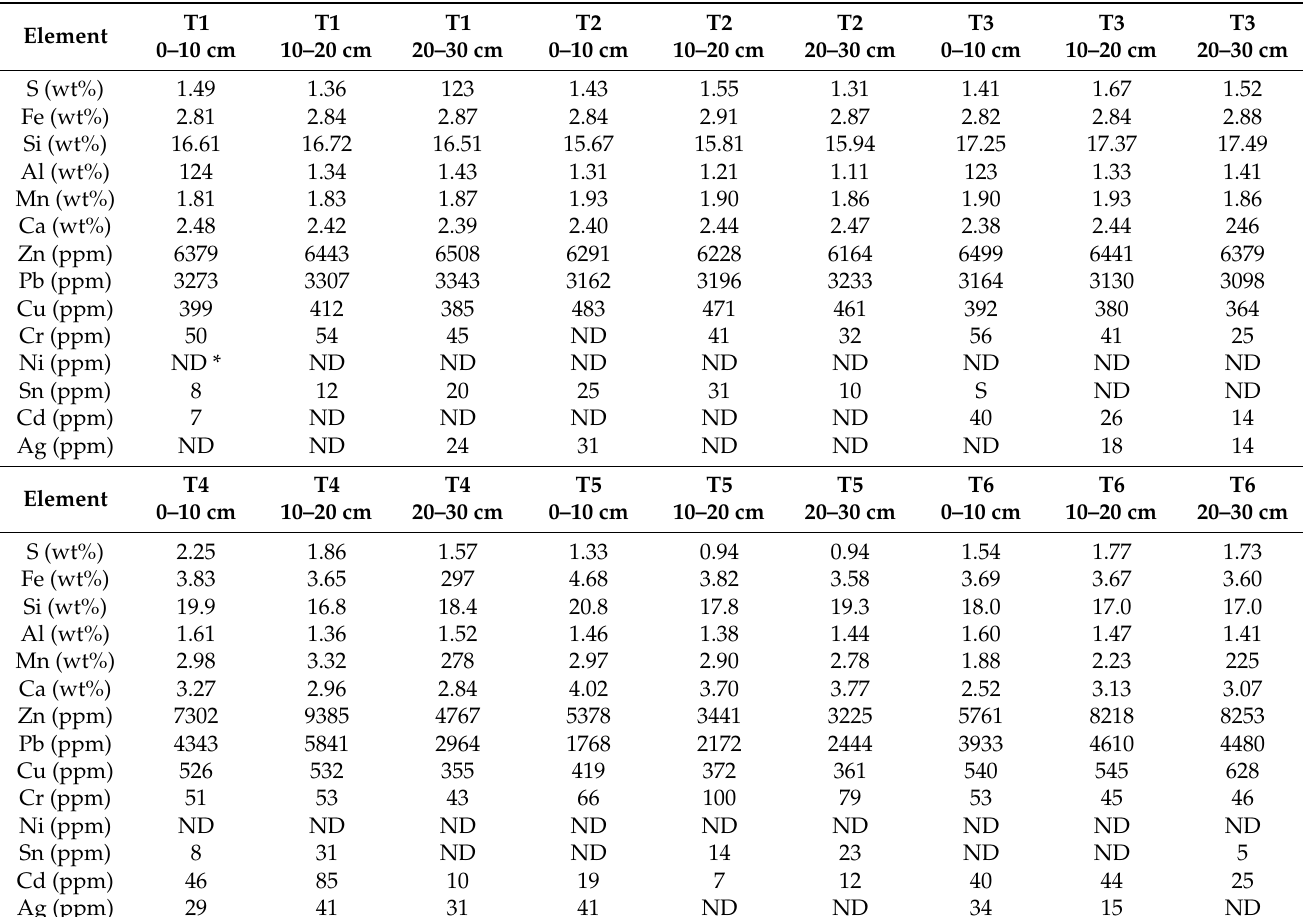
Table 1. Chemical composition of paste tailings